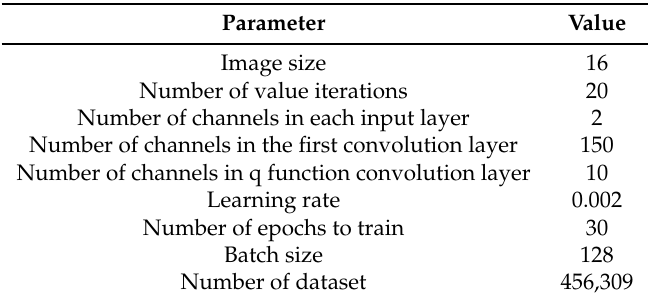
Table 1. HVIN Training Parameters.